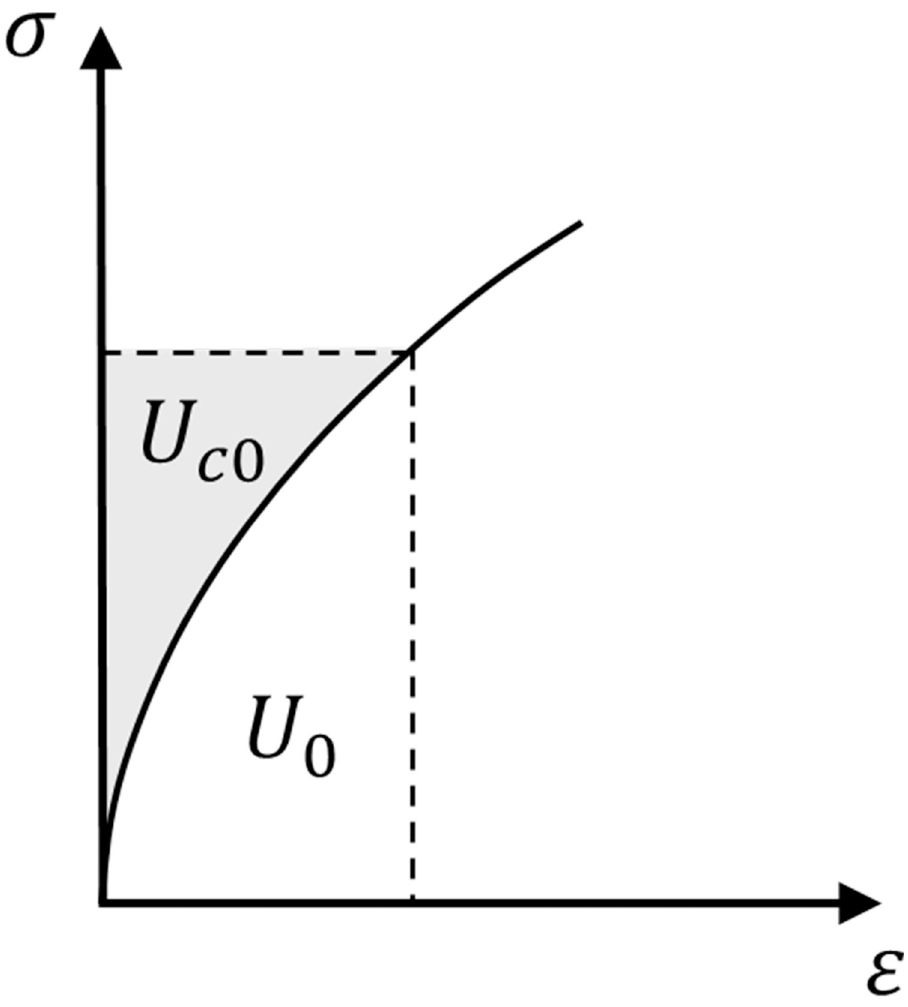
Fig 1. Strain energy for uniaxial